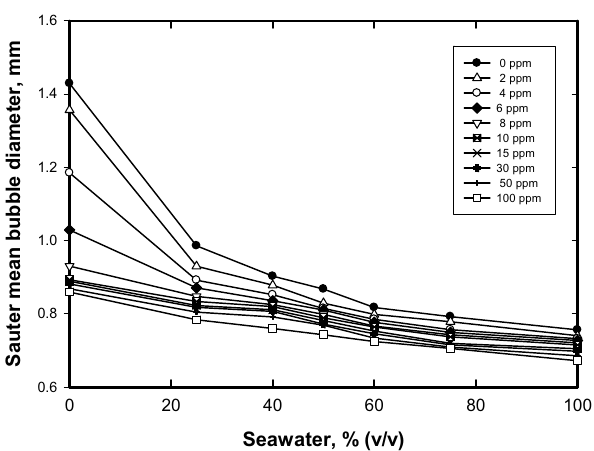
Fig. 6 Effect of MIBC frother on bubble size in seawater (Castro et al., 2010)